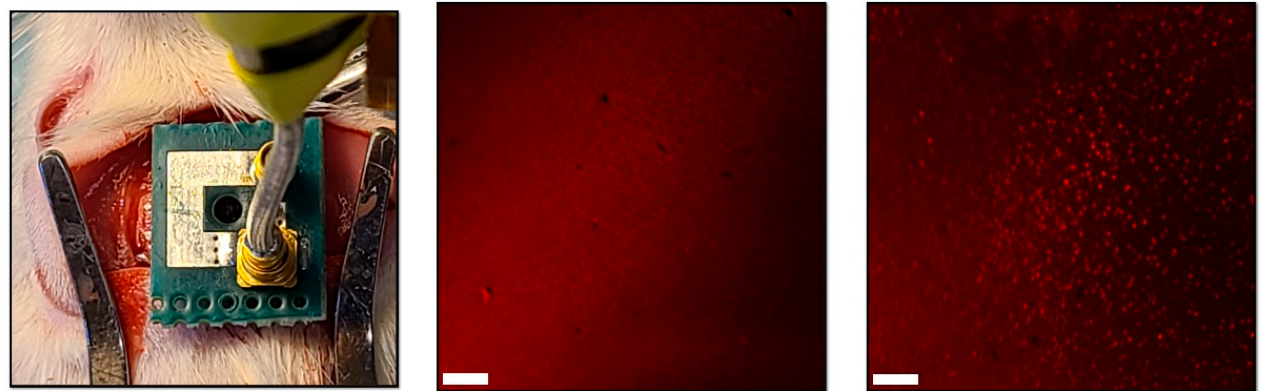
Figure 9. Technology validation using immunofluorescence imaging: Picture of the rat experiment during wireless stimulation. c-Fos expression in the left (control) and right (stimulated) hemispheres of a rat brain. Scale bar is 100 µm.